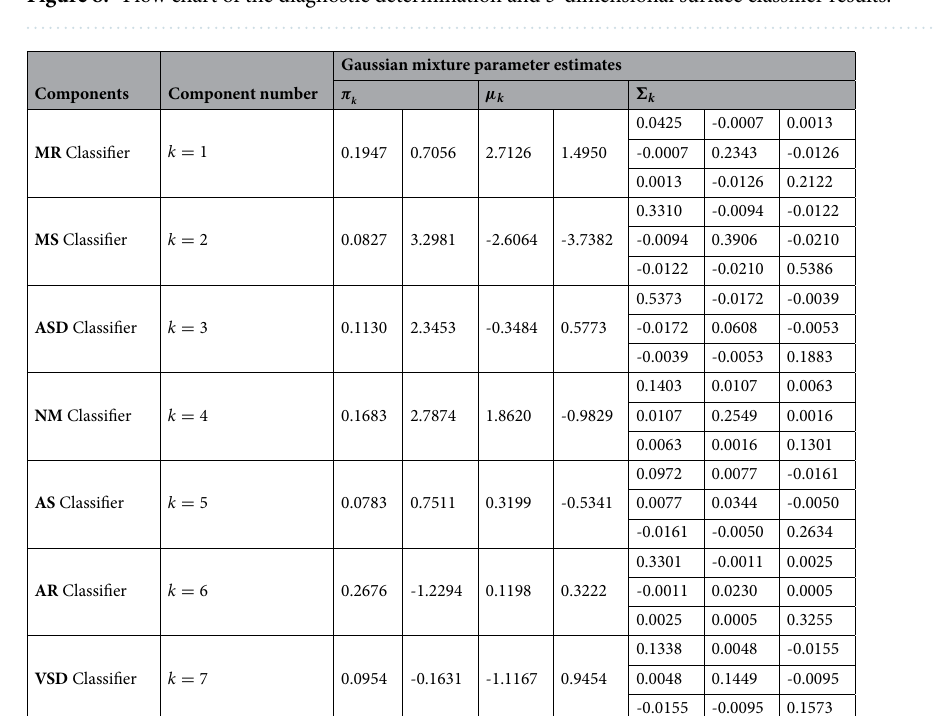
Figure 8. Flow chart of the diagnostic determination and 3-dimensional surface classifier results.